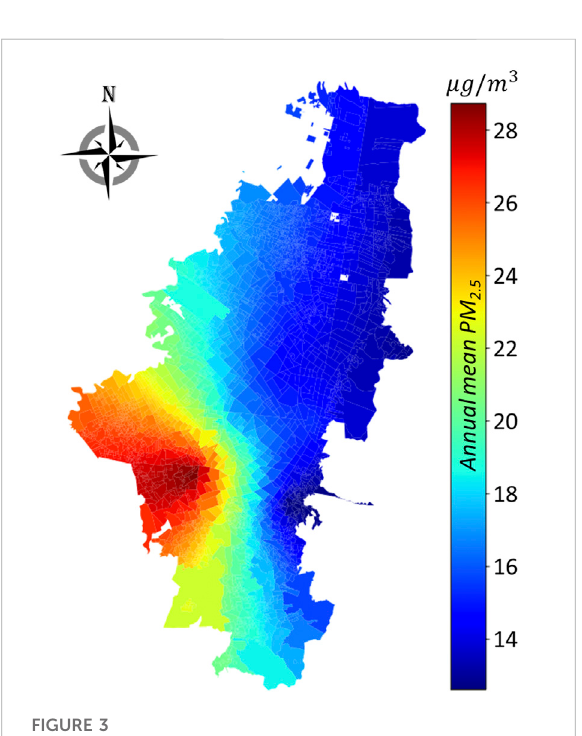
FIGURE 3 Annual ambient PM 2.5 concentration for year 2018. The spatial resolution is at the level of